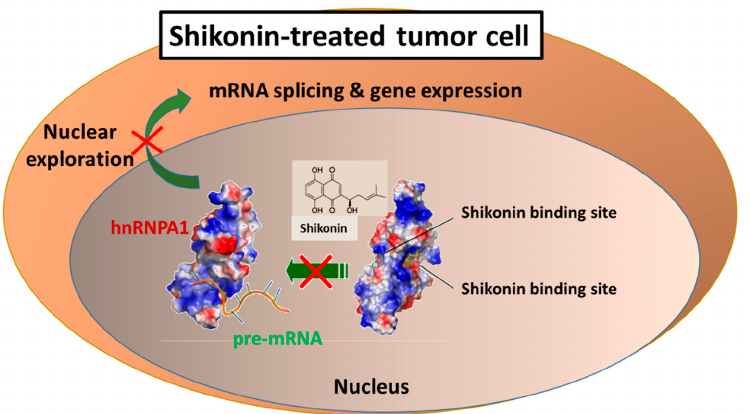
Figure 2. Identification of hnRNPA1 as a protein target provides pharmacological basis for diverse biochemical activities of shikonin. Docking models of the Shikonin binding to hnRNPA1, generated by AutoDock Vina and presented by a molecular visualization program,